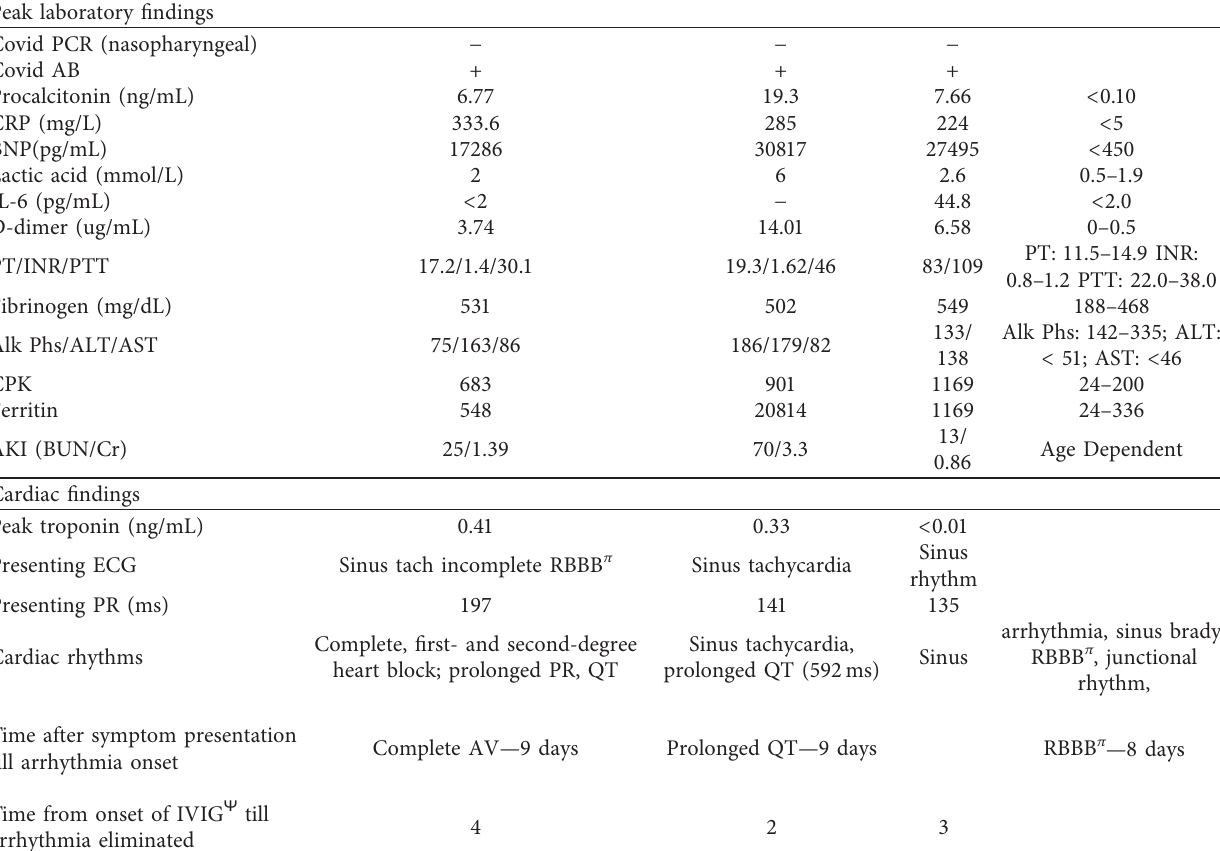
Table 2: Laboratory and cardiac